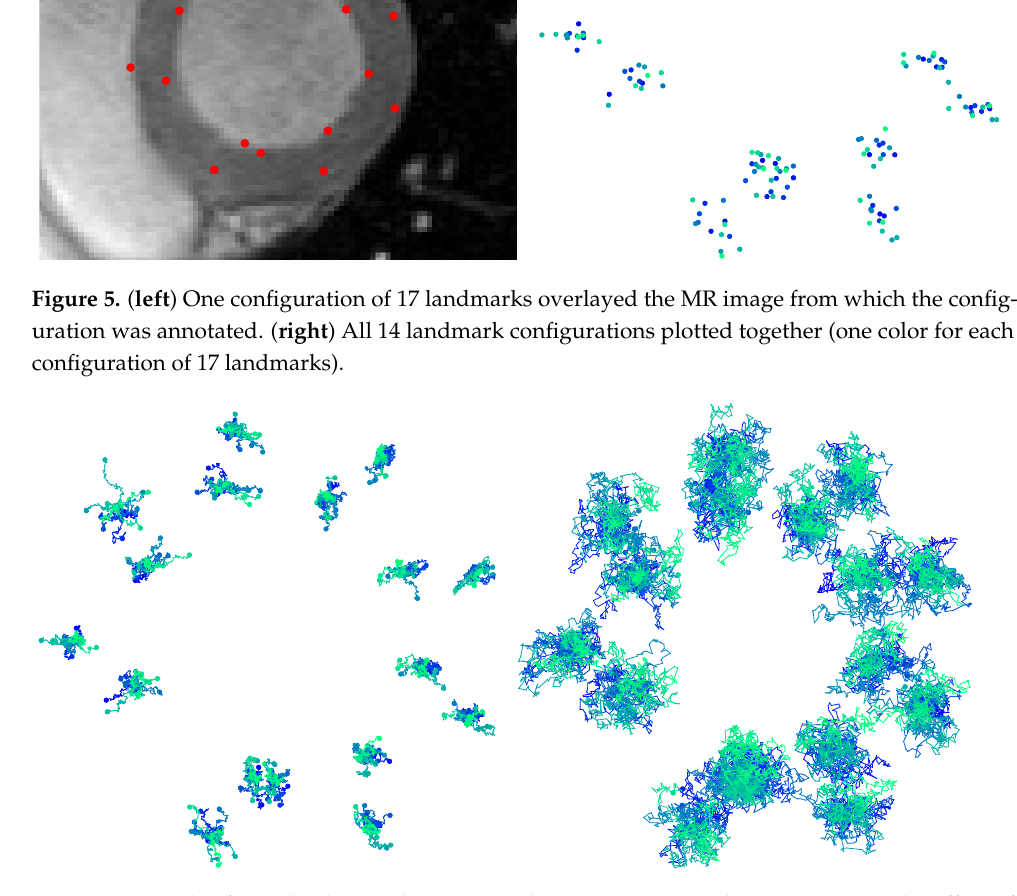
Figure 6. Samples from the diagonal process with T = 0.2 ( left ) and T = 1 ( right ). The effect of varying the Brownian motion end time T is clearly